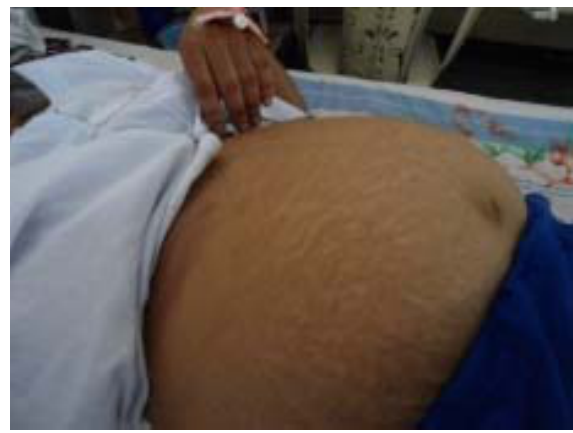
Figure 3. Abdominal obesity and lower abdominal purple